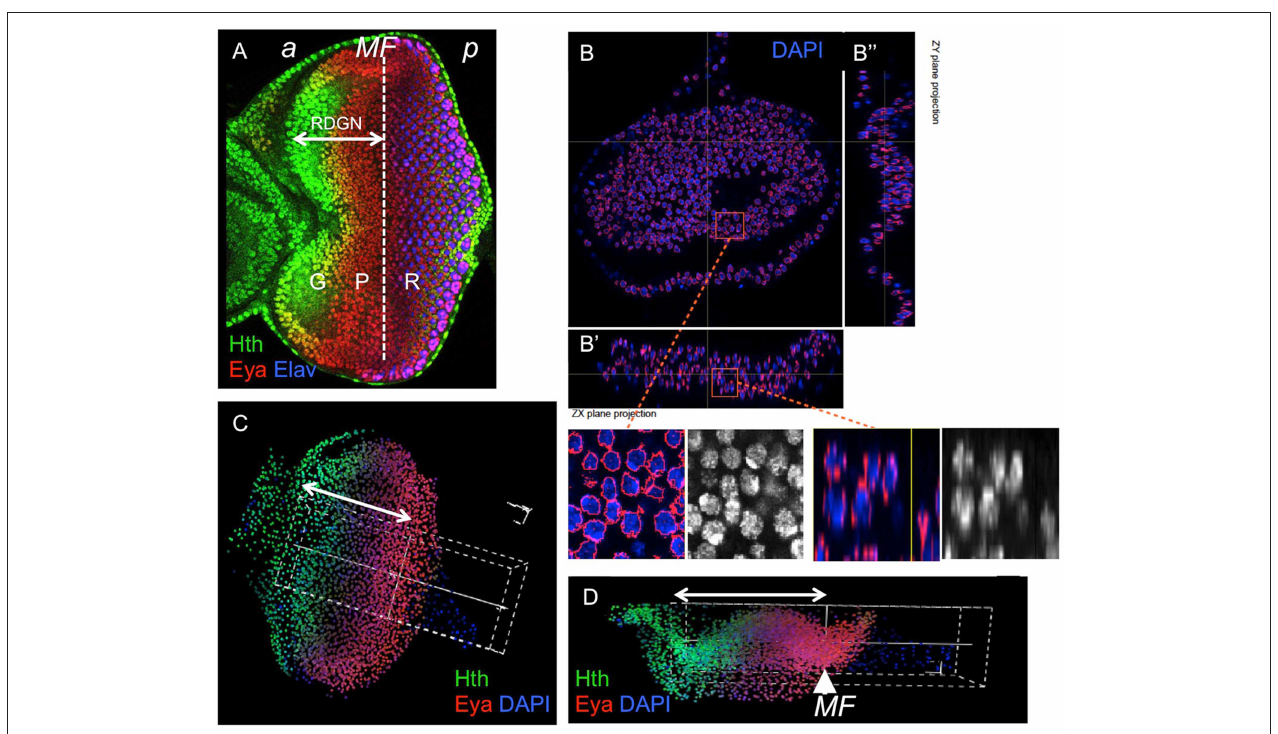
FIGURE 1 | Quantification of gene expression using confocal microscopy data in eye discs. (A) Confocal image of a late third larval stage (L3) eye disc, stained for Hth, Eya, and the photoreceptor marker Elav. These genes mark three major domains in the primordium: progenitors (“G”), precursors (“P”), and differentiating retina (“R”). The dashed line marks the approximate location of the morphogenetic furrow (MF). The retinal determination gene network (RDGN) comprises the regulatory interactions that span the specification of progenitors and their transition to atonal- expressing retinal precursors. “a” and “p” indicate anterior and posterior, respectively. The confocal data used in this study included the nuclear marker DAPI. Nuclei are segmented in 3D using iFLIC, a custom made software ′′ ( Sanchez-Aragon and Casares, 2019). When the segmented stacks are re-sliced (B–B ) , nuclear boundaries (RED) appear correctly located in most nuclei. The insets show higher magnification views of the boxed regions. (C,D) 3D reconstruction of an early disc showing a sampling volume (white dashed box) oriented parallel to the AP axis and centered at the morphogenetic furrow, stained with Hth, Eya and DAPI. (x,y) (A) and (x,z) (B) views are shown. The double-headed arrow indicates the region anterior to the MF. In general, the 3D reconstruction may be sampled in specific directions (white dashed box in A,B ), and the profiles for specific genes measured with high accuracy. The result is similar to a FACS analysis, but with the advantage of keeping the positional